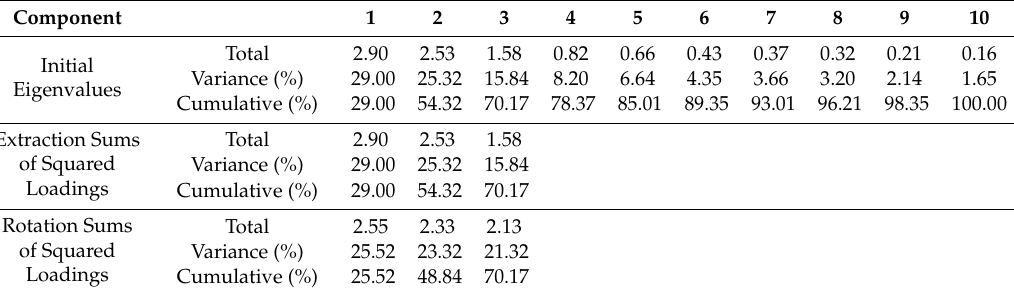
Table 6. The percentage of total variance explained by the